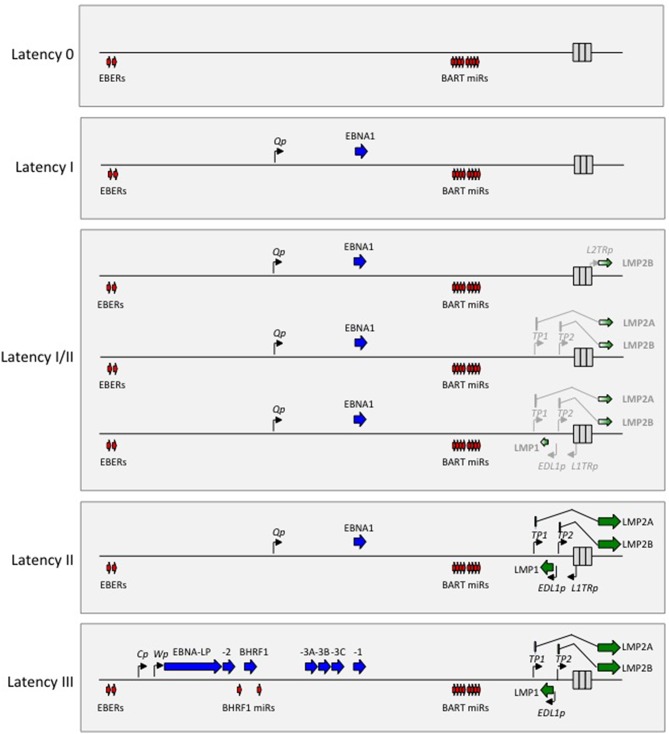
Diagrammatic representation of the alternate forms of EBV latency drawn on a linear map of the virus genome. Note that the non-coding EBER RNAs and the BART miRs are expressed in all forms of latency. Latency 0 represents an antigen-negative form of infection. Latency I involves selective expression of EBNA1 from the Bam H1Q promoter (Qp). Latency II involves expression of EBNA1 from Qp, LMP1 from the LMP1 promoter (EDL1p), LMP2A from the LMP2A promoter (Tp1) and LMP2B from the LMP2B promoter (Tp2). Latency I/II includes a number of latency profiles that are intermediate between Latencies I and II with different degrees of LMP1 and/or LMP2A and/or LMP2B expression (represented here by light shading); in some cases LMP2B is expressed from a different promoter (L2TRp) in the terminal repeat region. Latency III involves expression of all six EBNA proteins, BHRF1 and the BHRF1 miRs from the BamH1W (Wp) and/or BamH1C (Cp) promoters, plus LMP1, 2A, and 2B expressed from EDL1p, Tp1, and Tp2, respectively.